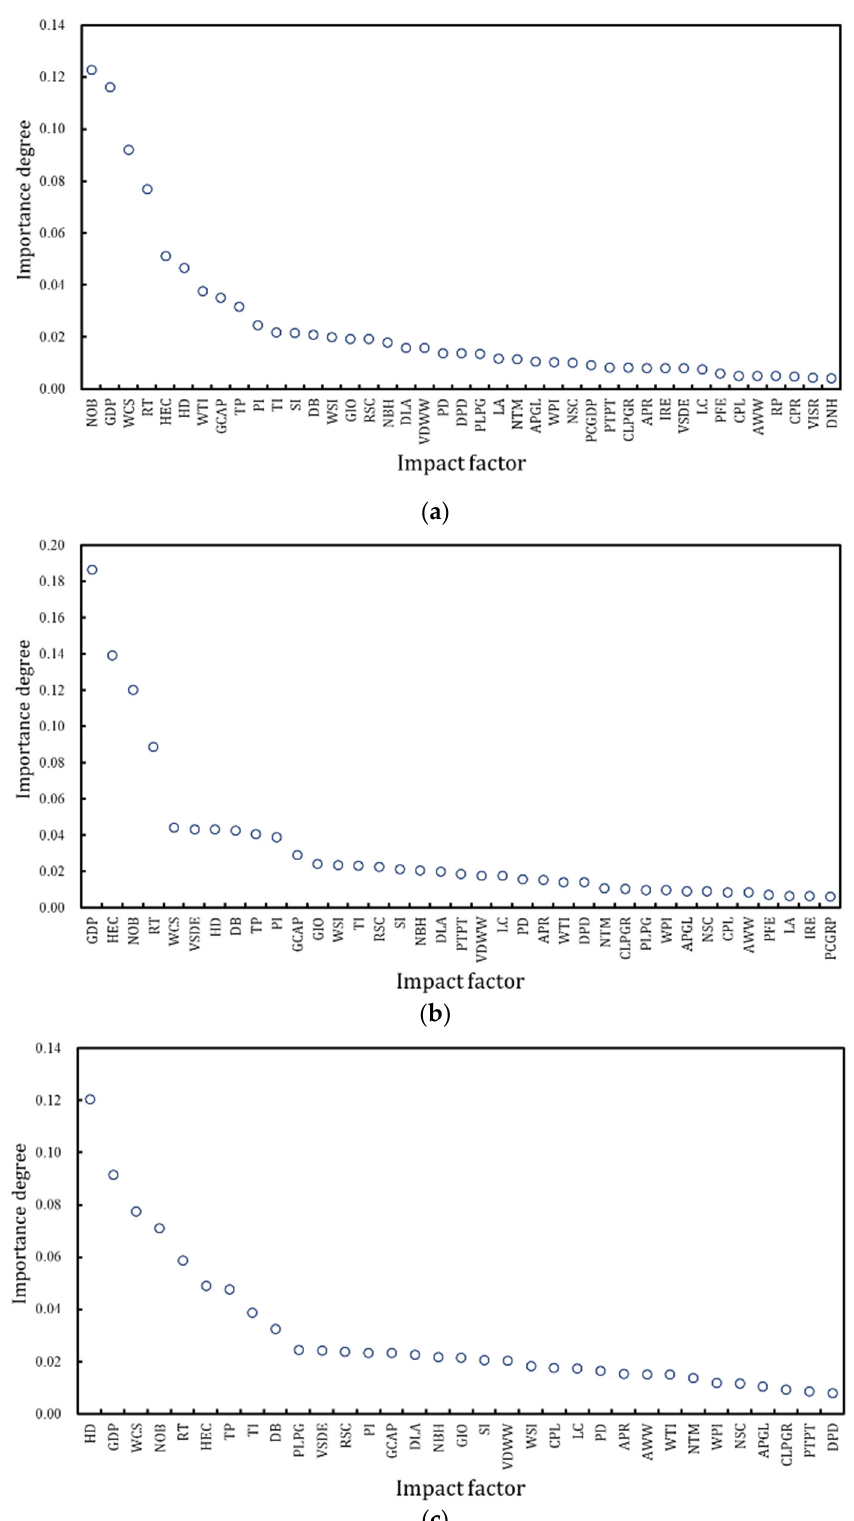
Figure 4. Importance degrees of impact factors. ( a ) The first iteration. ( b ) The second iteration. ( c ) The third iteration.